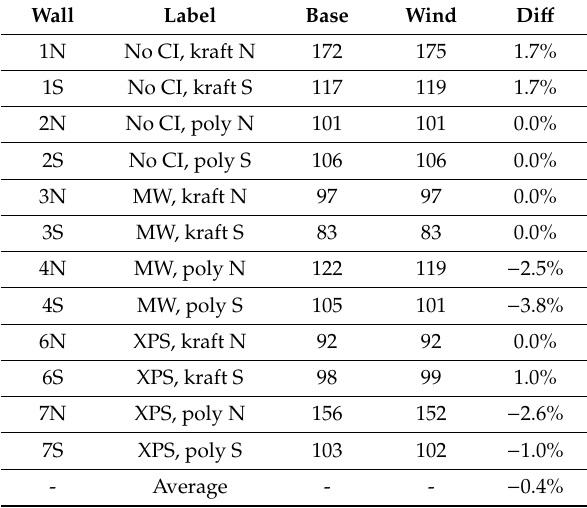
Table 5. Scaled error for select wall assemblies, with and without wind e ff ect on exterior surface thermal resistance.